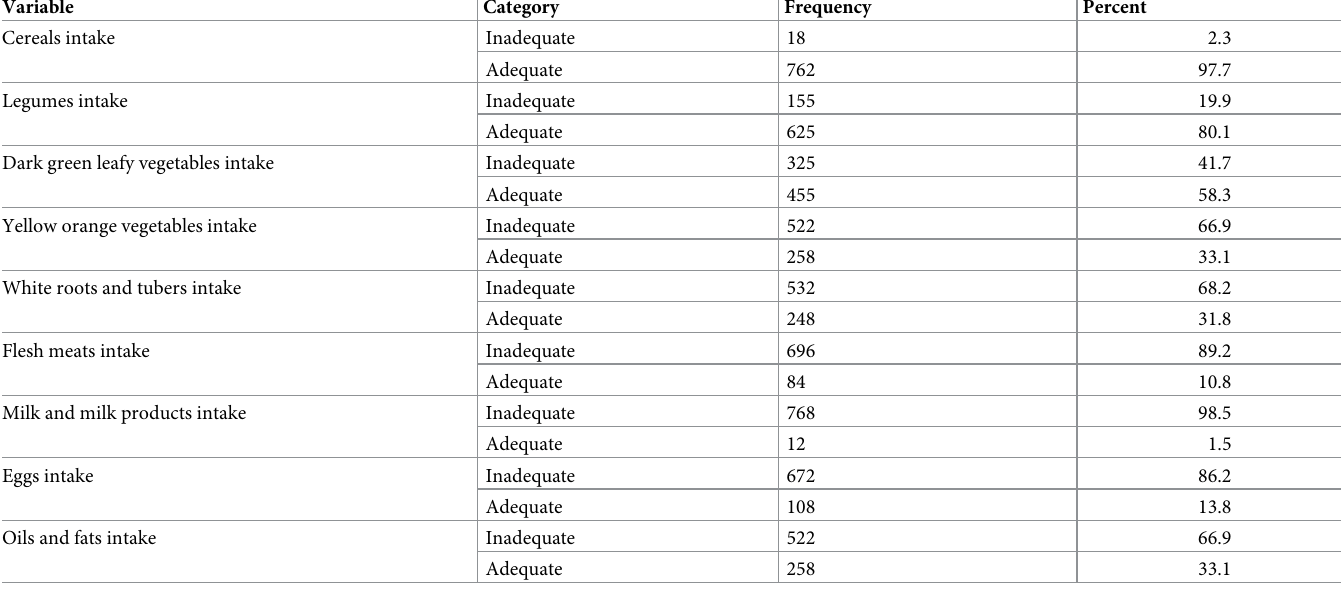
Table 4. Consumption of common food groups among participants attending ANC services at public hospitals of West Wollega Zone, 2020. Variable Cereals intake Legumes intake Dark green leafy vegetables intake Yellow orange vegetables intake White roots and tubers